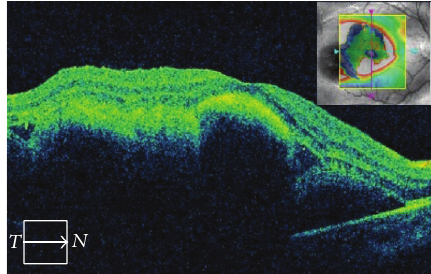
NT Figure 2: Submacular hemorrhage detected by optical coherence tomography.